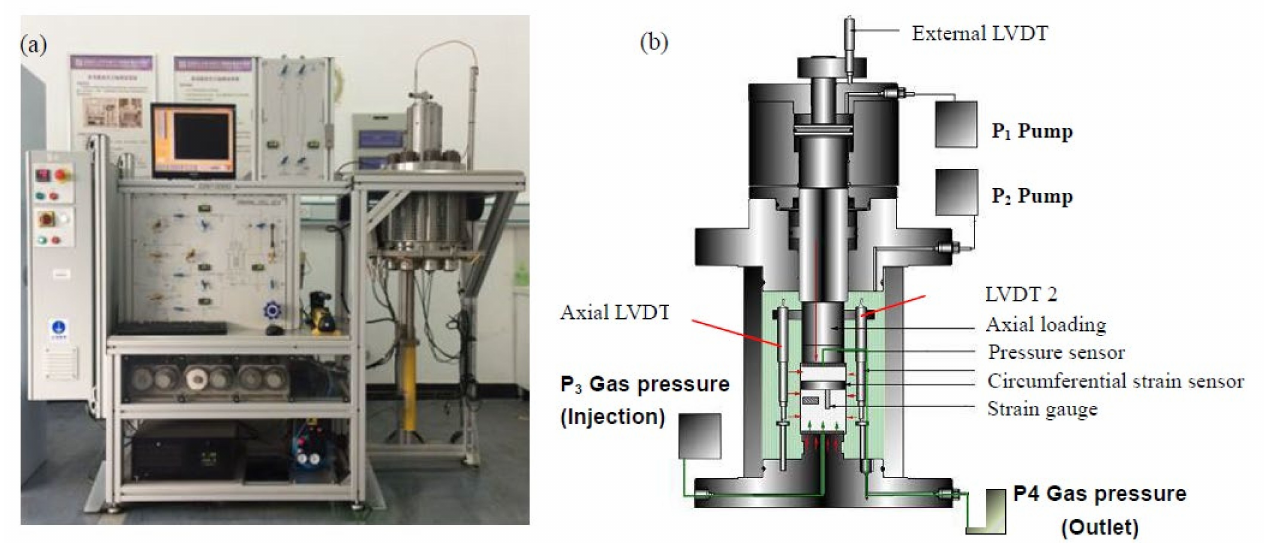
Figure 3. Rock tri-axial rheological testing apparatus ( a ) Testing equipment; ( b ) Specimen installation